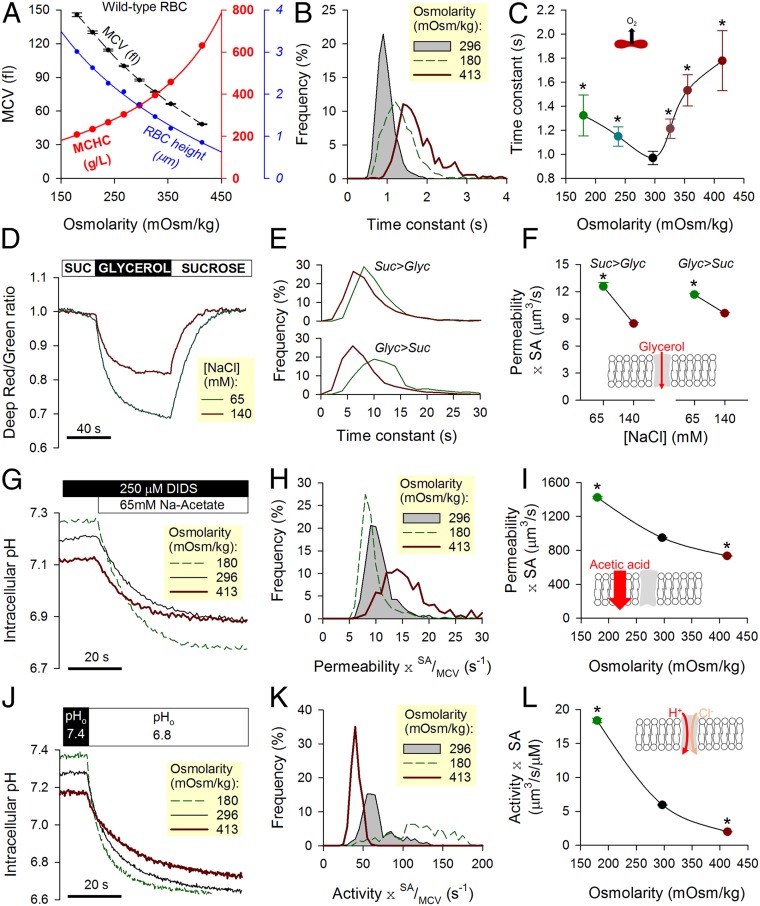
Effect of osmotic manipulations on transport properties in wild-type (WT) RBCs. (A) Changes in osmolarity brought about by adding or removing superfusate NaCl affect MCV, MCHC, and cell height (ratio of MCV to cell area). Mean ± SEM. (B) Both hypo- and hyperosmotic conditions slow the process of O2 unloading, which is quantified in terms of time constant τO2. (C) Biphasic relationship between osmolarity and τO2, with a nadir at physiological osmolarity. Mean ± variance (n = 3,688, 1,002, 3,680, 1,609, 895, and 841 from WT3 and WT4). (D) Deep-Red/Green ratio response to reversible cell swelling triggered by aquaporin-mediated glycerol influx under constant tonicity (100 mM glycerol replacing 100 mM sucrose). Experiments were performed under hypo- (+65 mM NaCl) and hypertonic (+140 mM NaCl) conditions. (E) Time constant of fluorescence ratio changes in response to glycerol influx (Upper) and efflux (Lower). (F) Glycerol permeability increases under hypotonic conditions. Mean ± SEM (n = 511 and 1,030 from WT3 and WT4). Equilibrium MCVs were 79 fL in 140 mM NaCl + 100 mM sucrose, 86 fL in 140 mM NaCl + 100 mM glycerol, 123 fL in 65 mM NaCl + 100 mM sucrose, and 148 fL in 65 mM NaCl + 100 mM glycerol. (G) pHi imaged in cSNARF1-loaded RBCs during a protocol that measures permeability to acetic acid. Cells were rapidly exposed to Na-acetate (65 mM) in the presence of DIDS (250 µM) to block AE1 activity. The rate of pHi change is a readout of acetic acid entry, which was measured over a range of osmolarity. (H) Hypo- and hyperosmotic conditions modestly affect membrane permeability to acetic acid. (I) A decrease in osmolarity modestly increases the product of acetic acid permeability and SA. Mean ± SEM (n = 930, 1,658, 1,500 from WT3 and WT4). (J) pHi imaged in cSNARF1-loaded RBCs during a protocol that measures AE1 activity. Extracellular pH was rapidly dropped from 7.4 to 6.8, and the rate of pHi change provides a readout of Cl−/OH− exchange, which was probed over a range of osmolarity. (K) Hypo- and hyperosmotic conditions affect AE1 activity. (L) A decrease in osmolarity increases the product of AE1 activity coefficient and SA. Mean ± SEM (n = 426, 730, 662 from WT3 and WT4). *Significant difference to physiological osmolarity.